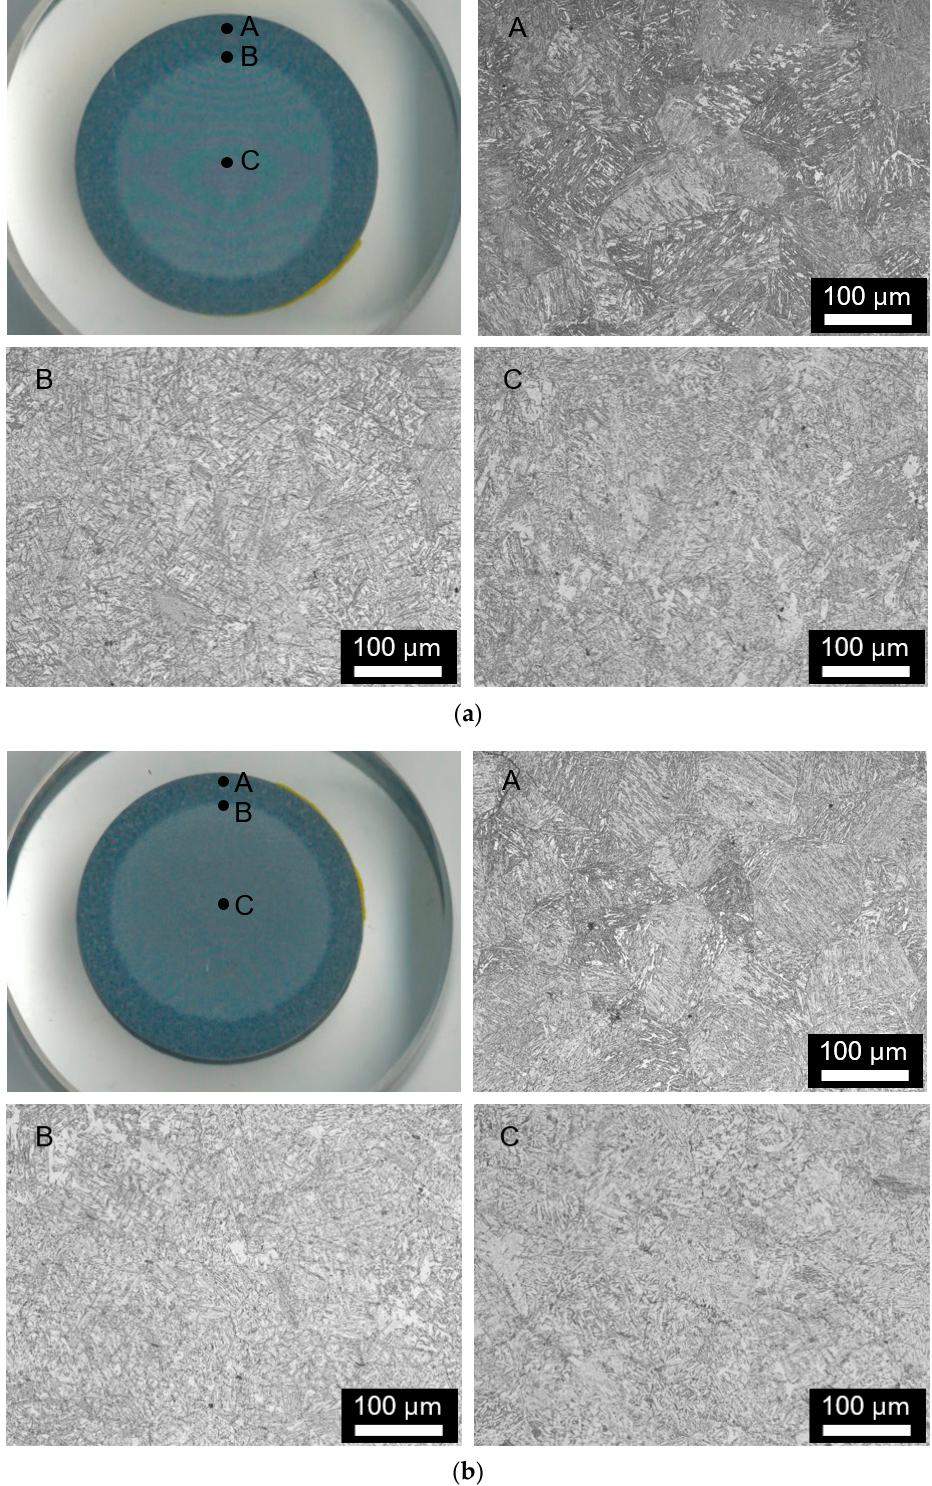
Figure 12. Tempered martensite rim obtained from TPS for ( a ) Type 1 and ( b ) Type 2.